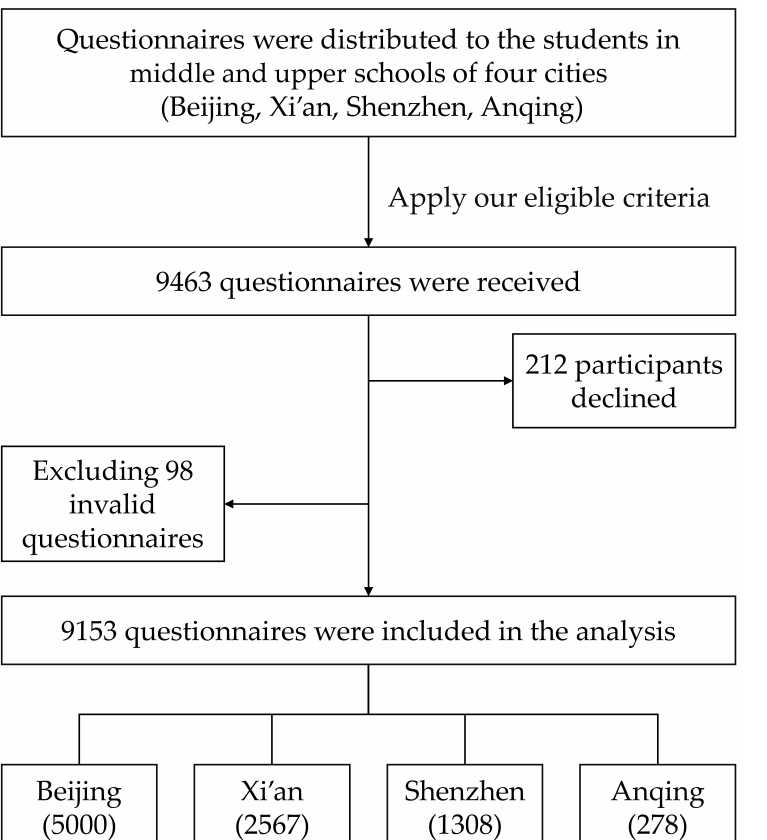
Figure 1. Recruitment flowchart for the cross-sectional survey among school students in grades 7–12 in four cities in